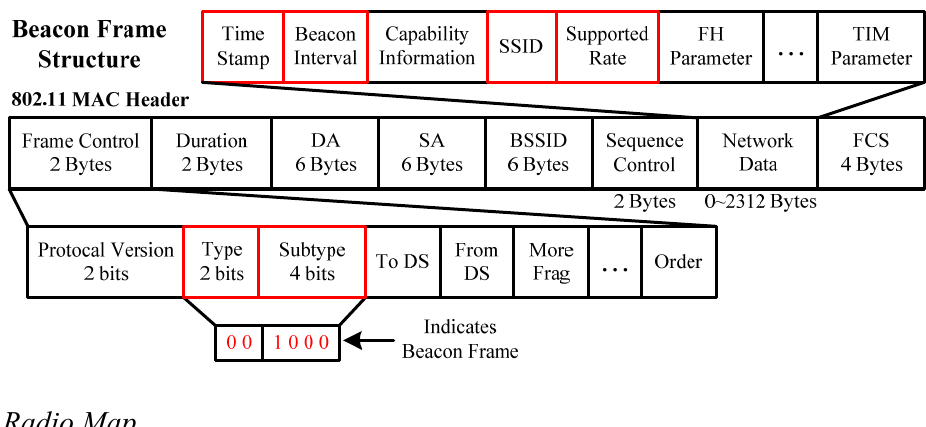
Figure 1. Main structure of a Beacon